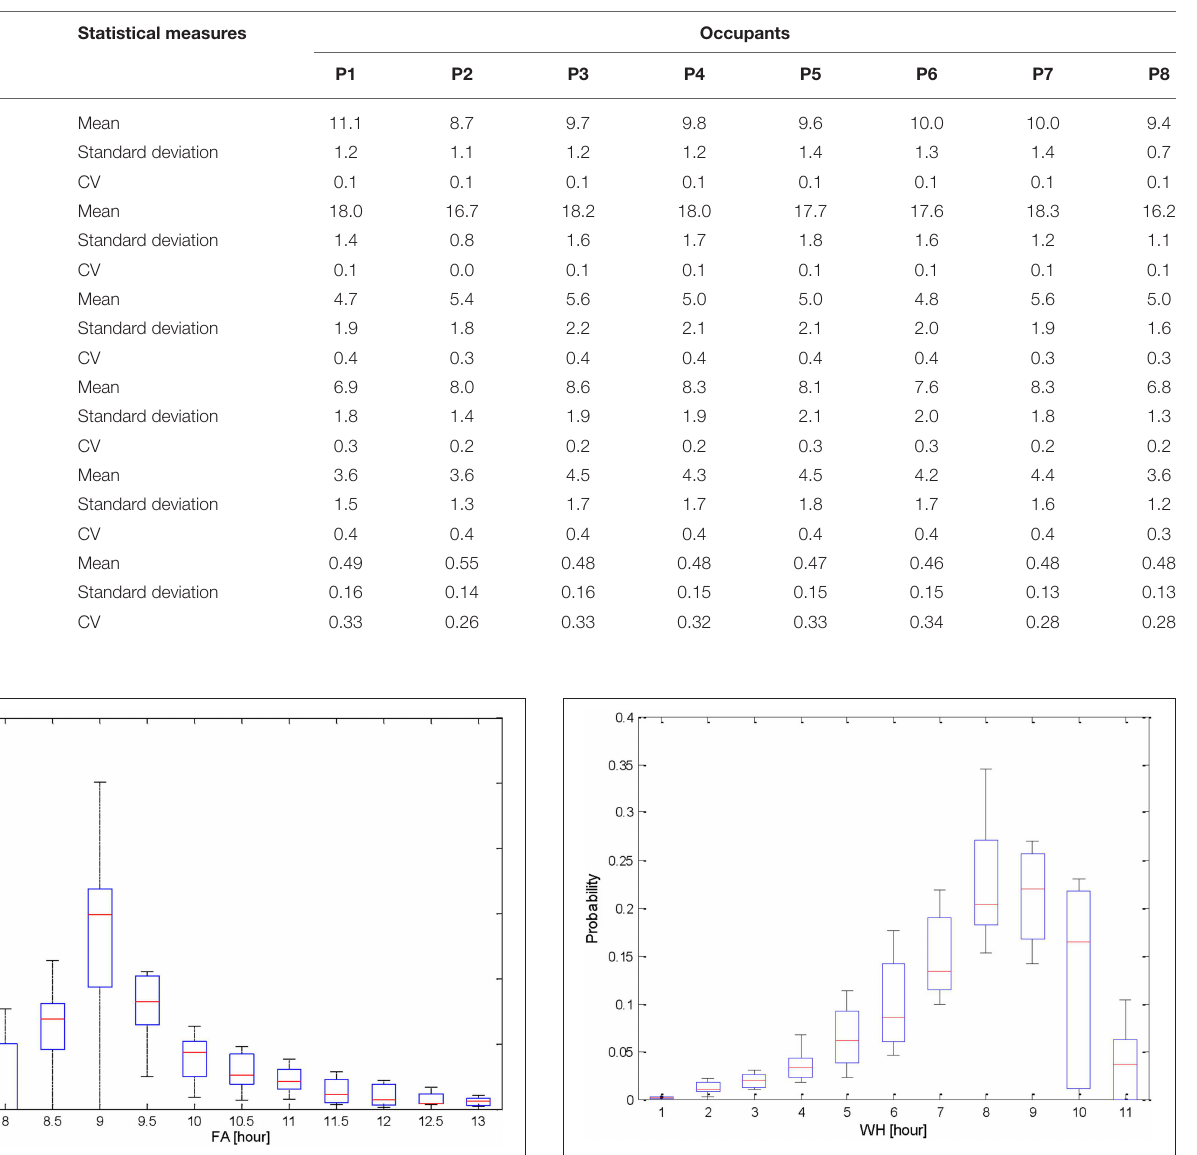
FIGURE 10 | Working hours boxplot. Reproduced from Mahdavi and Tahmasebi (2015) with permission from A. Mahdavi, and F. Tahmasebi.